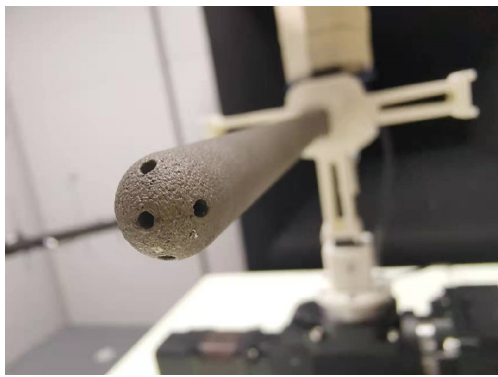
Figure 4. Five-hole probe made by 3D metal